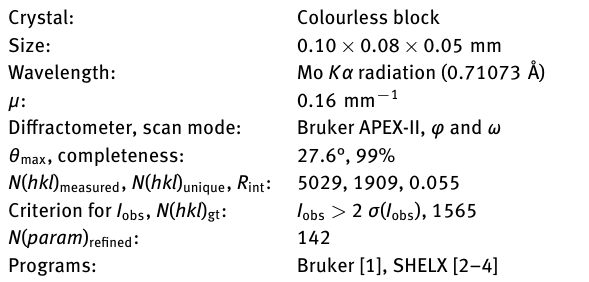
Table 2: Fractional atomic coordinates and isotropic or equivalent isotropic displacement parameters (Å 2